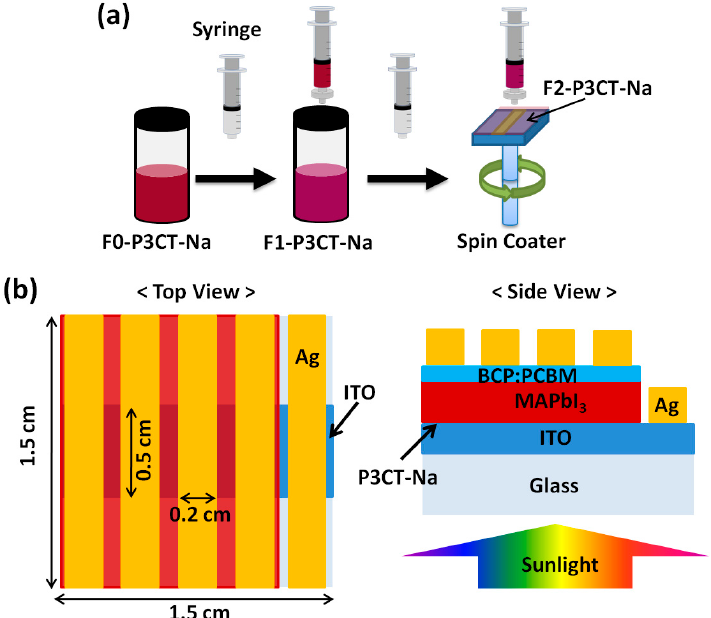
Figure 1. ( a ) Single-filtering and double-filtering processes for the P3CT-Na water solution. ( b ) Top view and side view of the device structure.